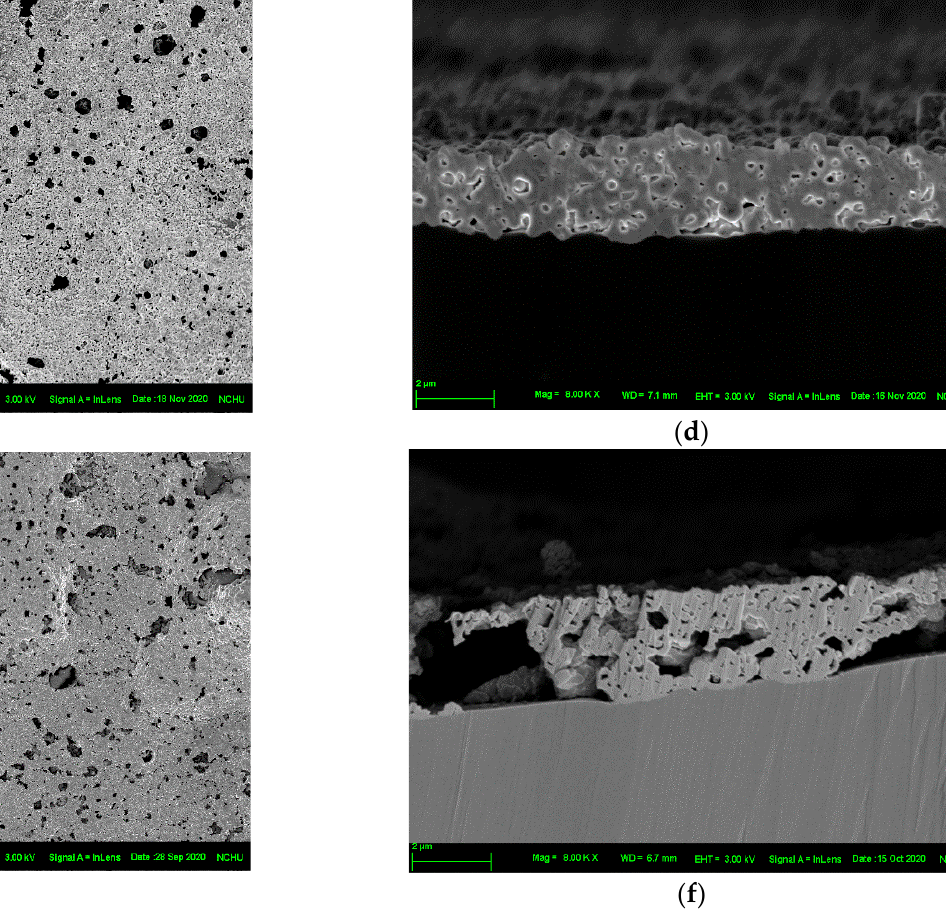
Figure 7. Top view and cross-sectioned images of the sintered structure on untreated PI substrate subjected to different bending cycles: ( a , b ) undeformed, ( c , d ) 50% of cycles to failure, ( e , f ) cycles to failure.